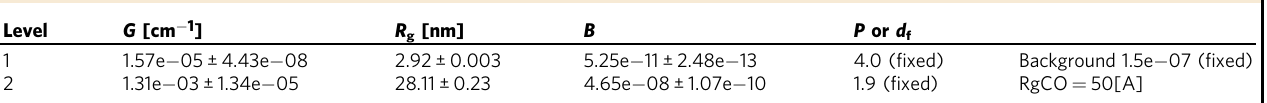
Table 1 Coef fi cients of the two-level uni fi ed fi t of Fig.